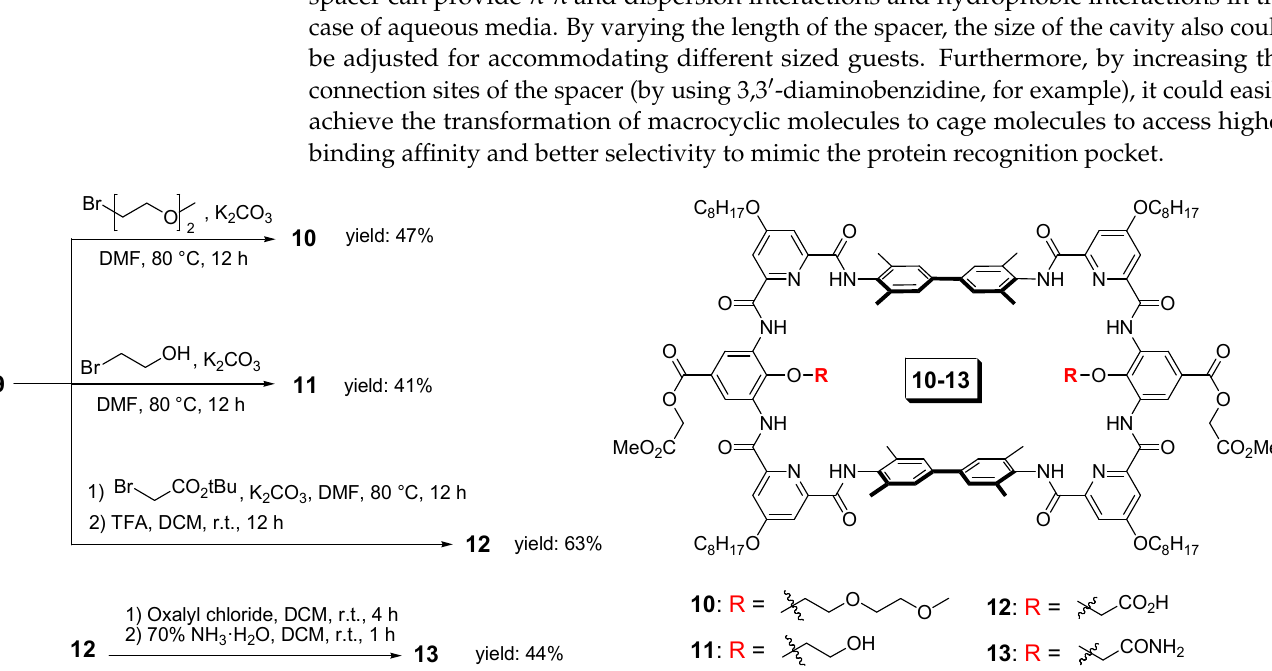
Figure 2. Variation of functional groups on the parent macrocycle ( 9 ). Here, shows the synthesis of compounds 10 – 13 as an example.